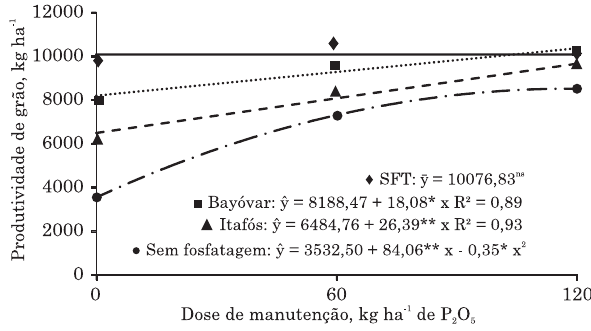
Figura 3. Produtividade de grãos de milho cultivado em um Cambissolo sergipano no primeiro ano em função da adubação fosfatada corretiva e das doses de manutenção. ns , * e **: não significativo e significativo a 5 e 1 %,